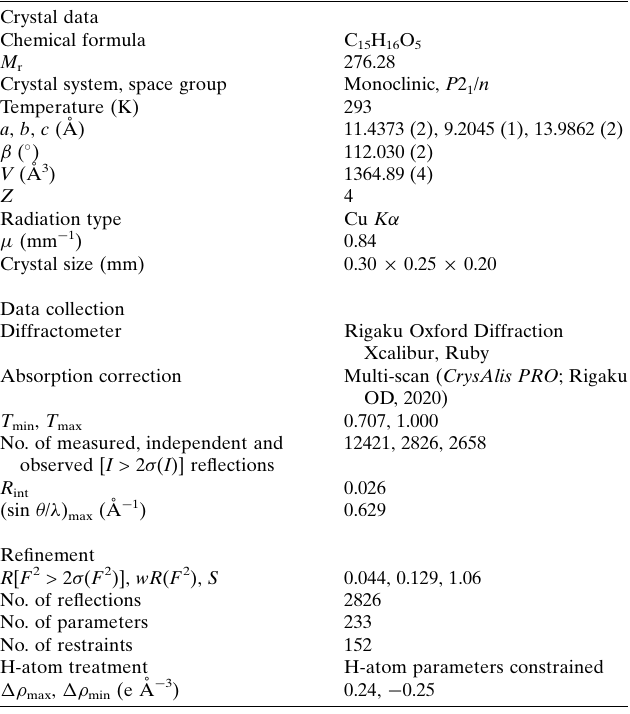
Table 2 Experimental details. Crystal data Chemical